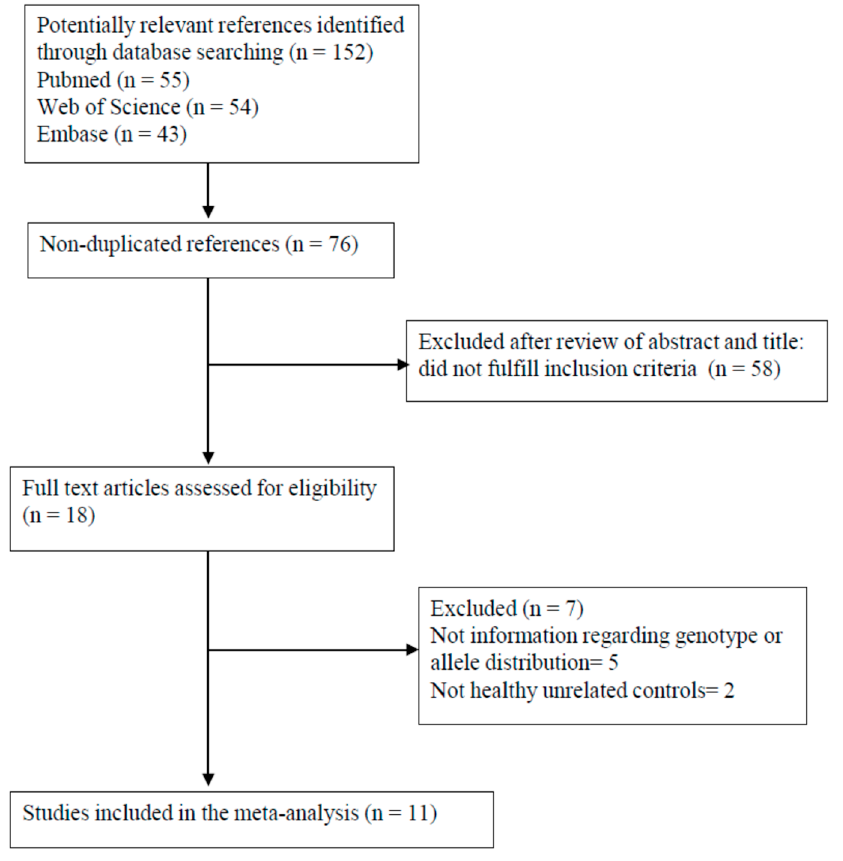
Figure 1. Flowchart of the selection of studies for inclusion in the meta-analysis.